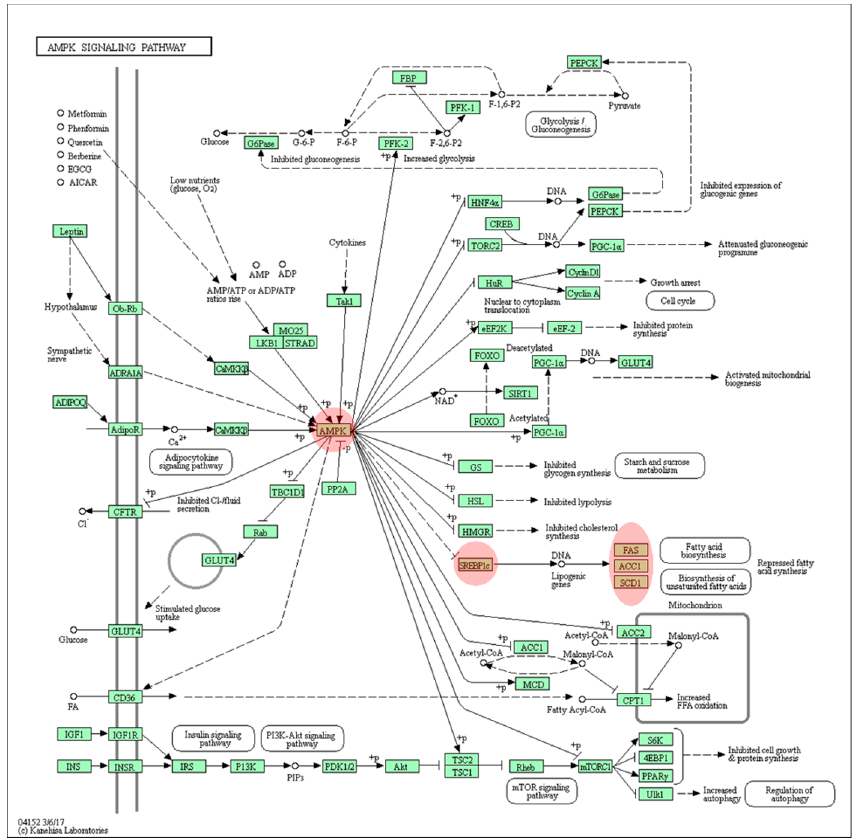
Figure 6. KEGG AMPK signaling. The AMPK signaling pathway was predicted as the most enriched pathway from the KEGG pathways analysis provided by the DAVID tools. The key player genes are highlighted with red color.